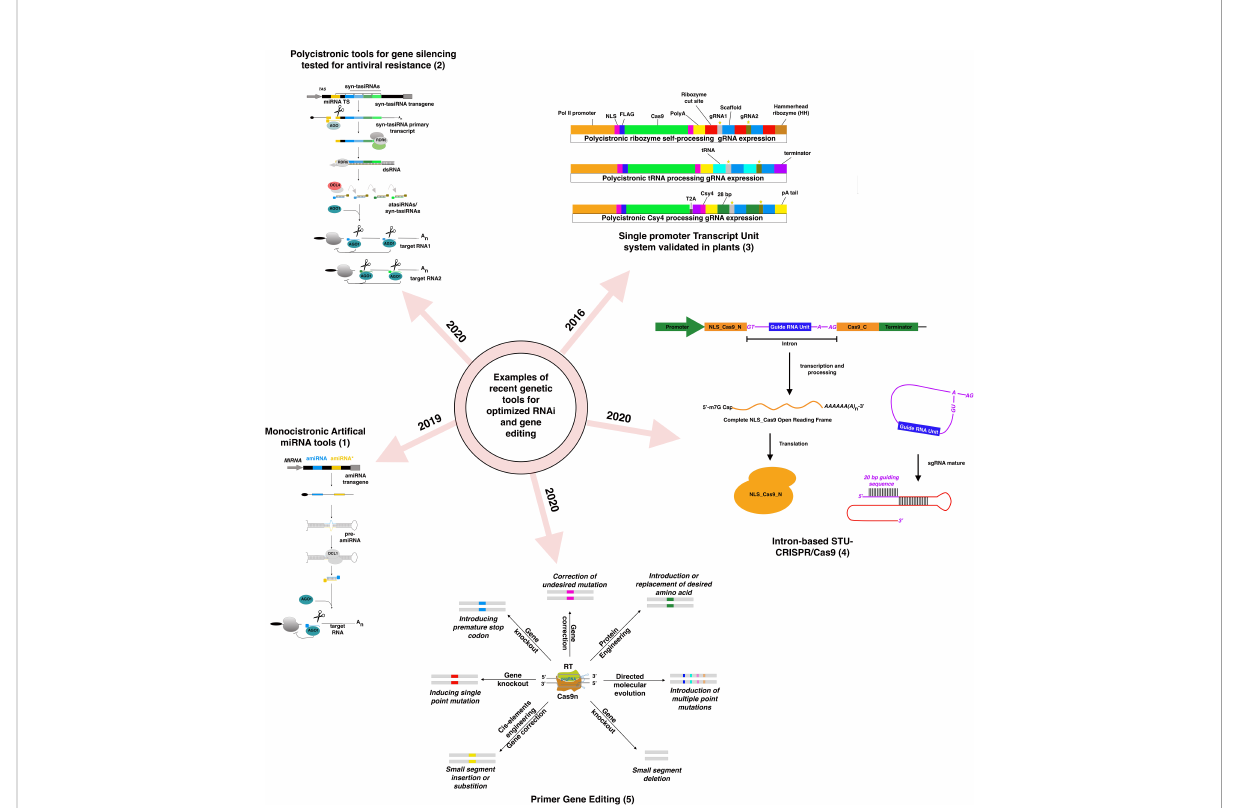
FIGURE 1 Examples of recently developed and validated genetic tools in plants for RNAi-silencing and DNA-based gene editing based on fi gures from previously published fi gures: (1) (Carbonell, 2019), (2) (Cisneros and Carbonell, 2020), (3) (Lowder et al., 2016), (4) (Zhong et al., 2020), (5) (Hassan et al.,